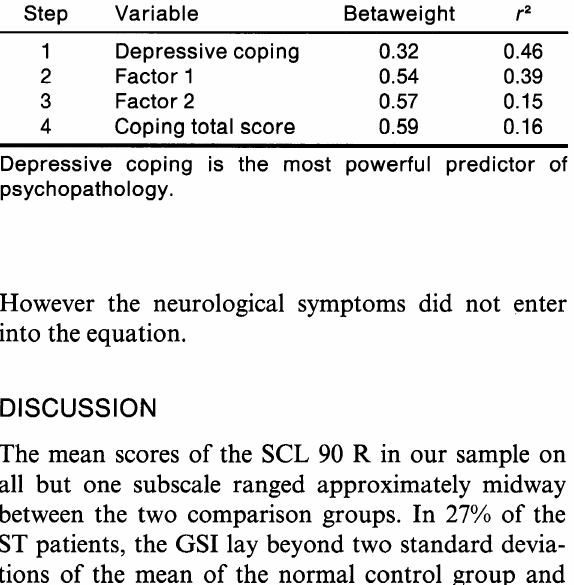
TABLE III. Multiple regression analysis with GSI as dependent variable